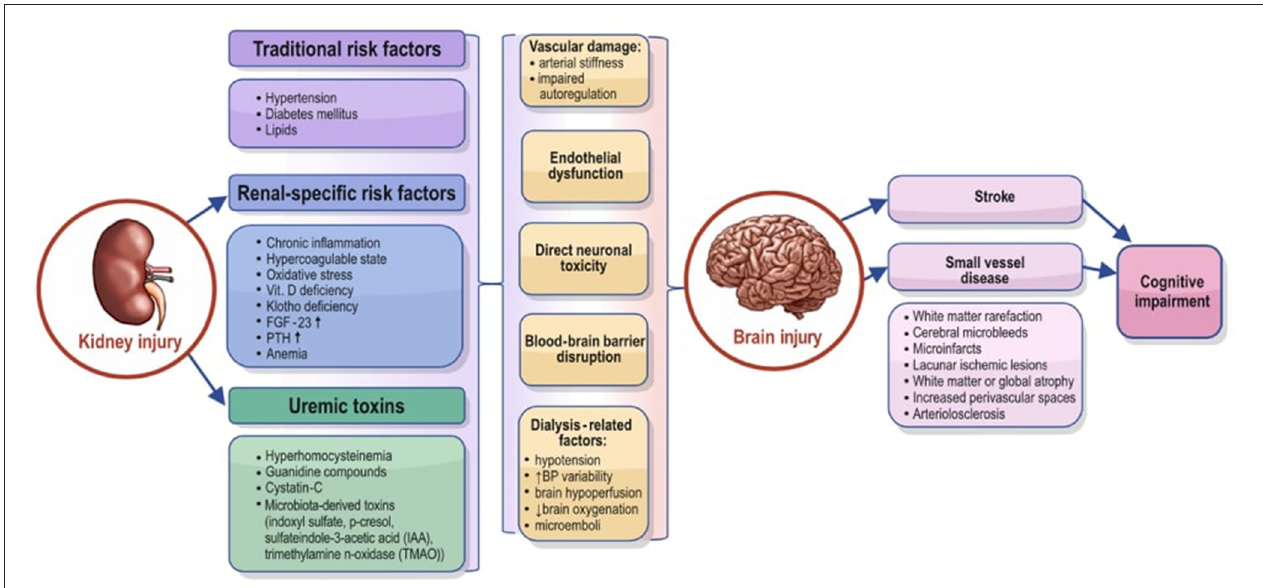
FIGURE 1 | Possible mechanisms that can explain the association between chronic kidney disease and brain injury. FGF-23, fibroblast growth factor 23; PTH, parathyroid hormone; IAA, sulfateindole-3-acetic acid; TMAO, trimethylamine n-oxidase.